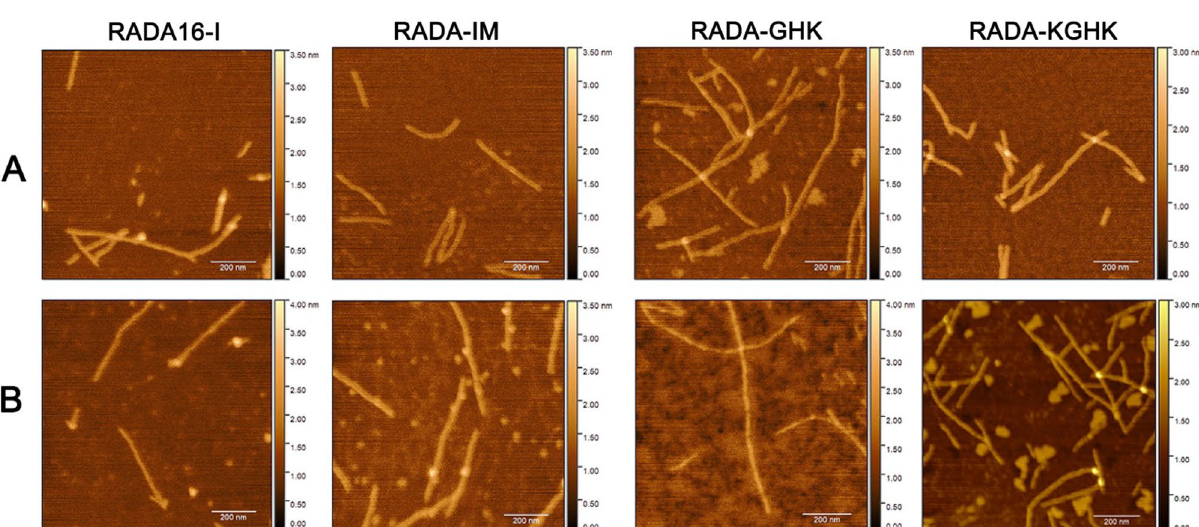
Figure 5. AFM images of RADA16-I and RADA hybrids after incubation in aqueous solution ( A ), and after sonication and reassembly over 24 h ( B ).